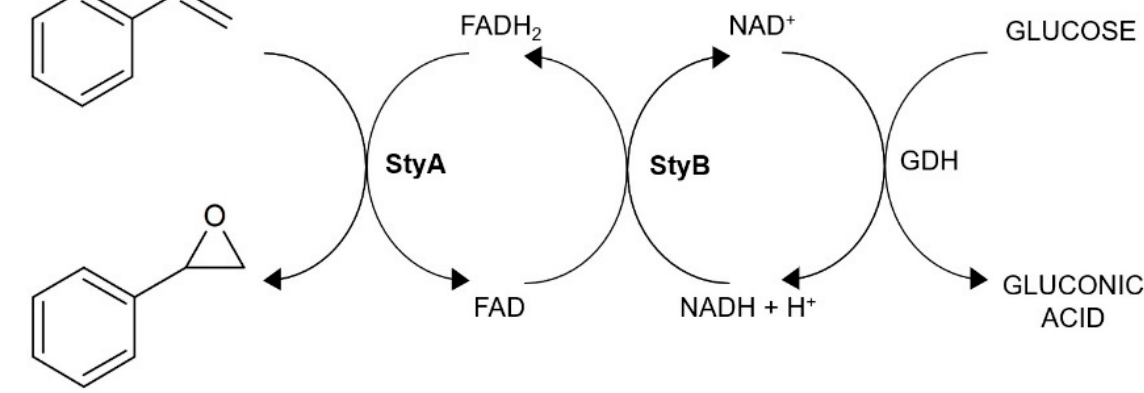
Figure 2. Biocatalytic cascade of styrene epoxidation involving GDH cofactor regeneration system. SMO exhibited a maximum activity at pH 7.8, but was highly active at the range 7.7–8.3 (Figure 3a). Since gluconic acid was formed in the reaction (Figure 2), a pH of 8